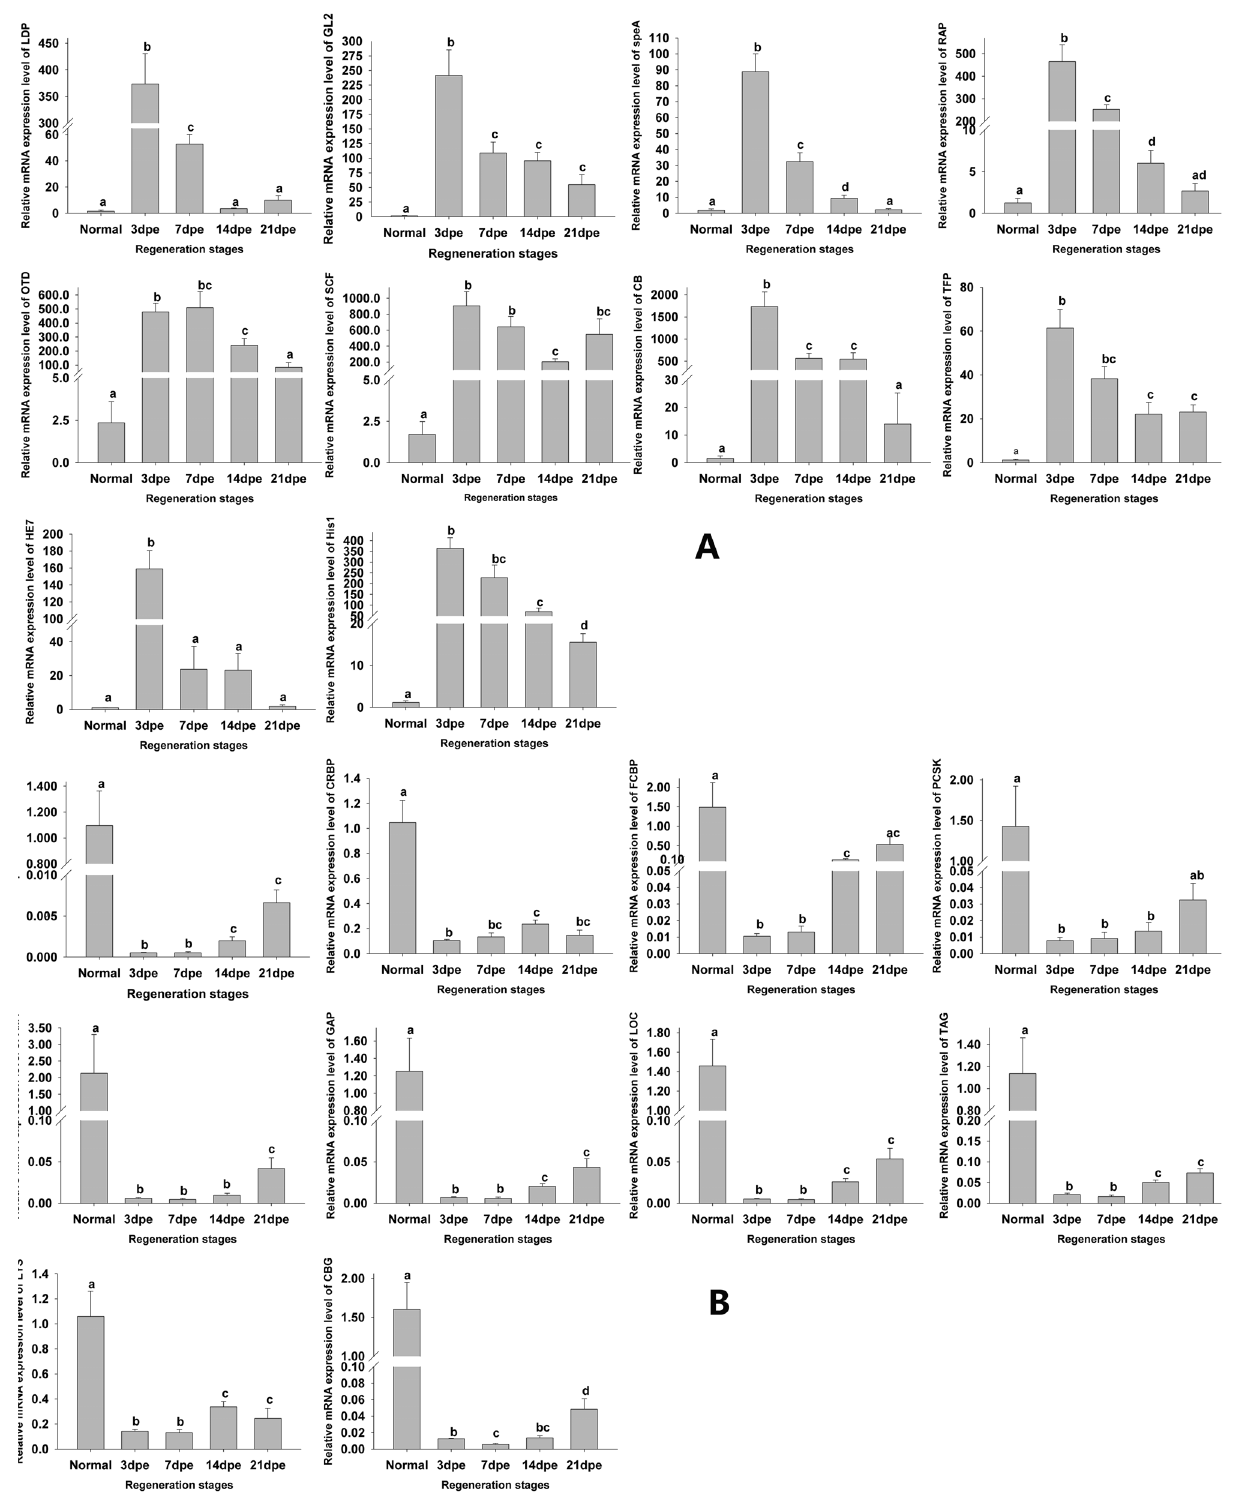
Figure 3. Real-time PCR analysis for top 10 up-regulated and 10 down-regulated genes. (A). LDP: low density lipoprotein-related protein 2-like; GL 2: GL12416-like isoform 2; speA: speedy A; RAP: regeneration associated protein; OTD: orthodenticle SCF: solute carrier family 6 member 9 transcript-like; CB: cyclin B3 TFP: TFP250 HE7: Hu/elav isoform 7; his1: cleavage stage histone H1. (B). Rp2: Rp2 Lipase; CRBP: cellular retinol-binding protein type 1b; FCBP: fatty acid binding protein 2, intestinal; PCSK: proprotein convertase subtilisin/kexin type 9; AMY: alpha-amylase; GAP: FG-GAP repeat family protein; LOC: LOC495367 protein; TAG: triacylglycerol lipase, pancreatic; LYS: lysozyme; CBG: cytosolic beta-glucosidase-like. Different lowercase letters indicate significant differences (P , 0.05). Values indicate the mean 6 S.E. (N=5).